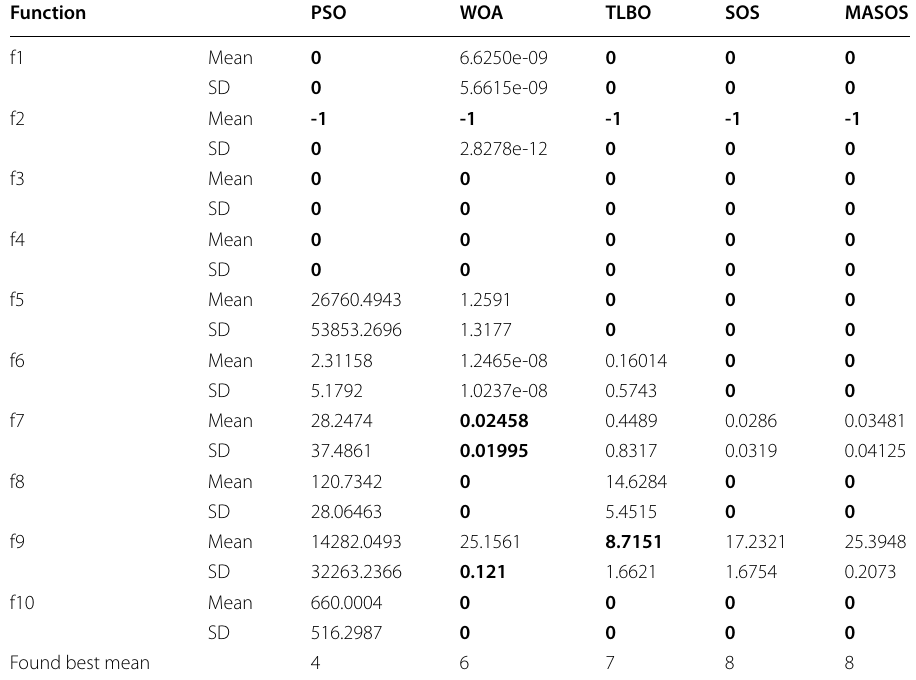
The best results are highlighted in bold